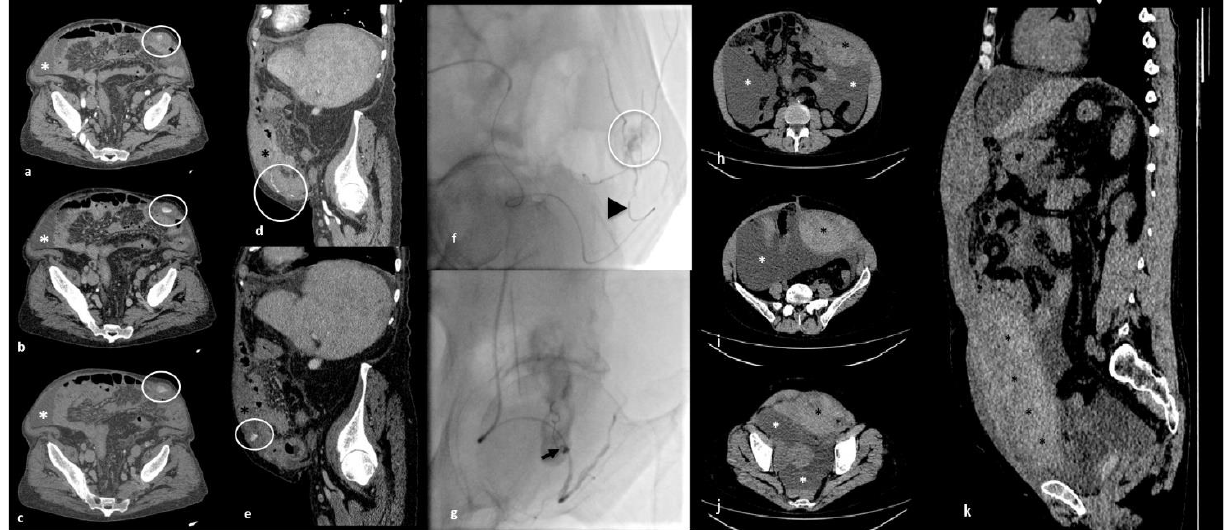
Figure 1. Imaging findings of the two patients. First patient‘s contrast-enhanced CT images: axial view of arterial ( a ), venous ( b ) and delayed ( c ) phases; sagittal CT-multiplanar reconstruction (MPR) ( d , e ); diagnostic angiography ( f ); and transcatheter arterial embolization ( g ). Ascites (white asterisk); extensive anterior abdominal wall hematoma (black asterisk) with evidence of active bleeding (white circle); angiographic microcatheter (black arrowhead); metallic spiral (black arrow). Second patient‘s non-contrast-enhanced CT images: axial scans ( h , i , j ) and sagittal MPR ( k ). Conspicuous ascitic collections (white asterisk); extensive anterior abdominal wall hematoma (black asterisk).